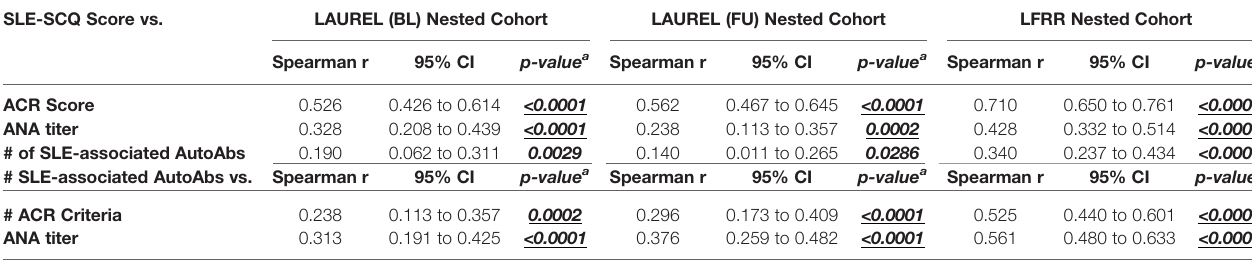
TABLE 7 | Correlation Between SLE-CSQ Score, ACR Score, and SLE-Associated Autoantibody Speci fi cities in Lupus Relatives. SLE-SCQ Score